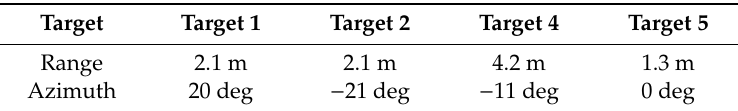
Table 6. Target positions in Experiment